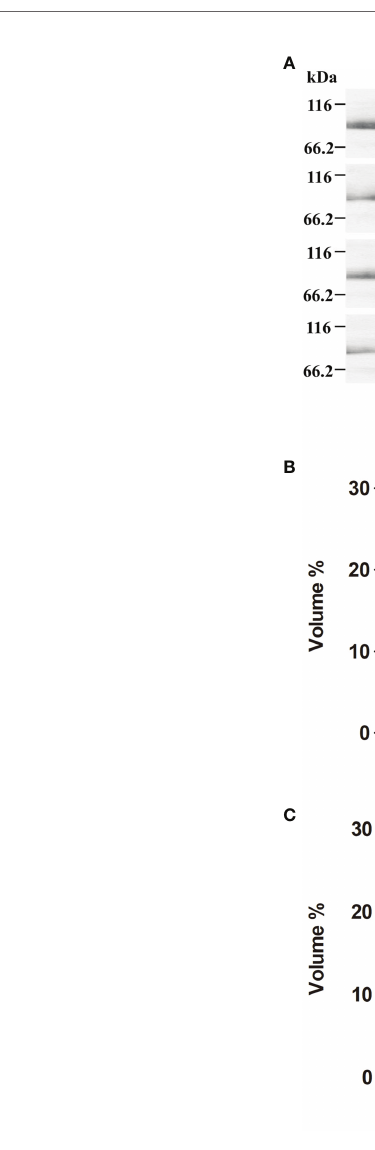
FIGURE 2 | 2-DE analysis of the hemocyanin from L. vannamei infected with pathogenic bacteria. (A) 2-DE analysis of 30 µg hemocyanin from L. vannamei treated with S. agalactiae (left) and V. parahaemolyticus (right) for 0 – 24 h; 0 h samples were used as control. (B, C) The expression level is normalized by densitometry analysis using the image analysis software PDQuest Analysis Software (Bio-Rad); 0 h samples were used as control. * p < 0.05, ** p <